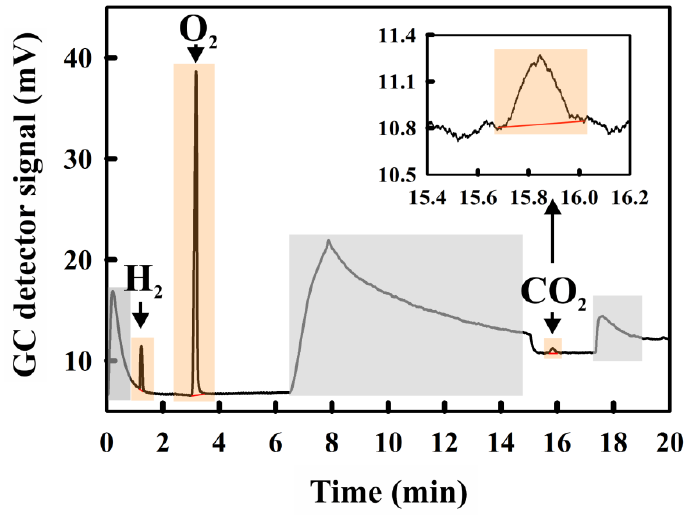
Figure 1. Gas chromatography (GC) chromatogram for a gas sample containing H 2 , O 2 , and CO 2 (orange shaded regions), respectively. Inset: expanded view of the CO 2 peak; grey shaded regions: the background output due to the injection artefact (0–1 min) due to transient mixing of the N 2 carrier gas with the sample, the temperature ramp (start at 6.5 min), and residual dirt in the column (17 min).